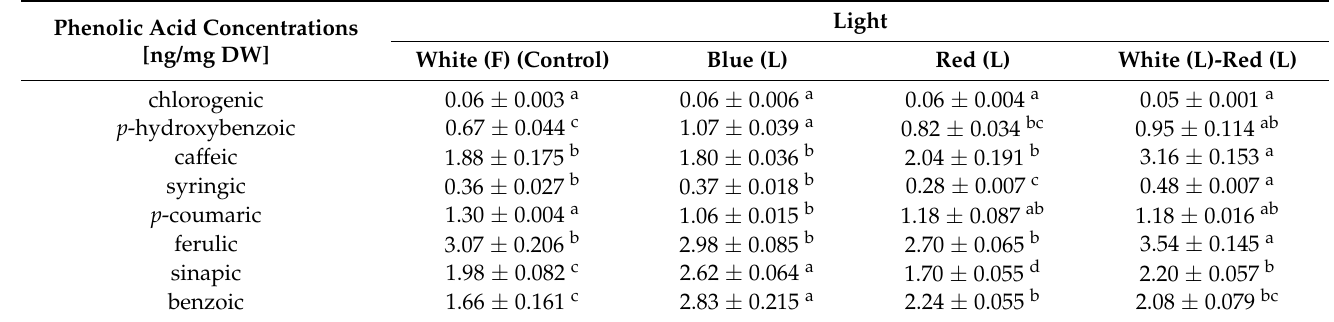
Table 3. Phenolic acid concentrations in extracts of L. aestivum in vitro cultures. The results are means of 3 replicates ( n = 3) ± SD. Different letters indicate a significance difference at p < 0.05 according to ANOVA and Duncan’s test. F: fluorescence, L: LED light, DW: dry weight.